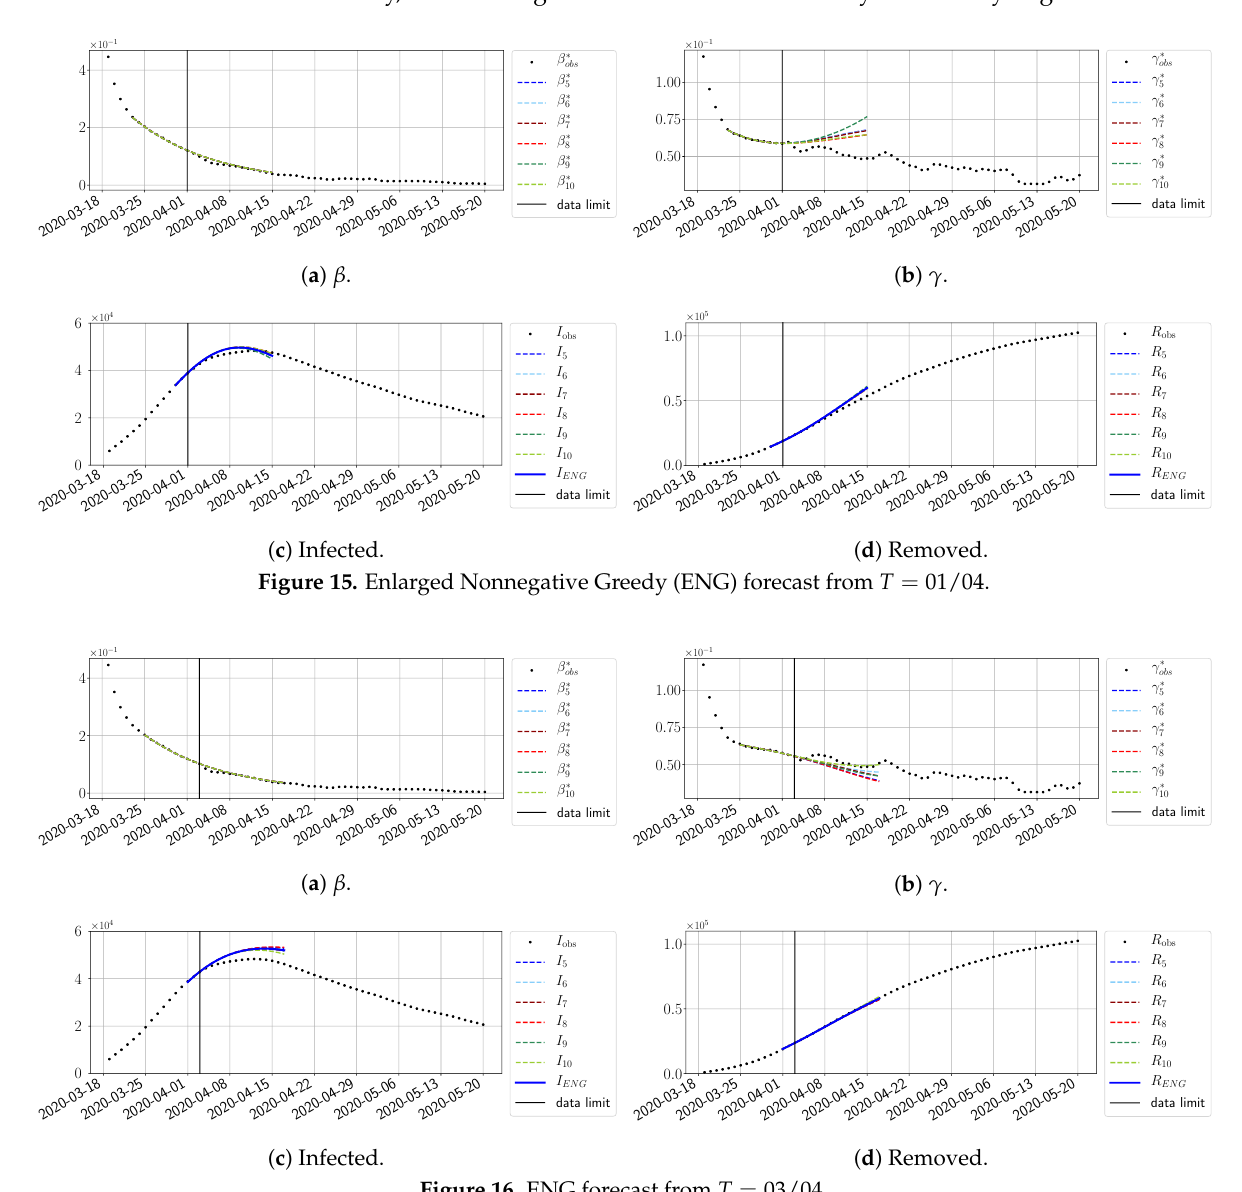
Figure 16. ENG forecast from T = 03/04.